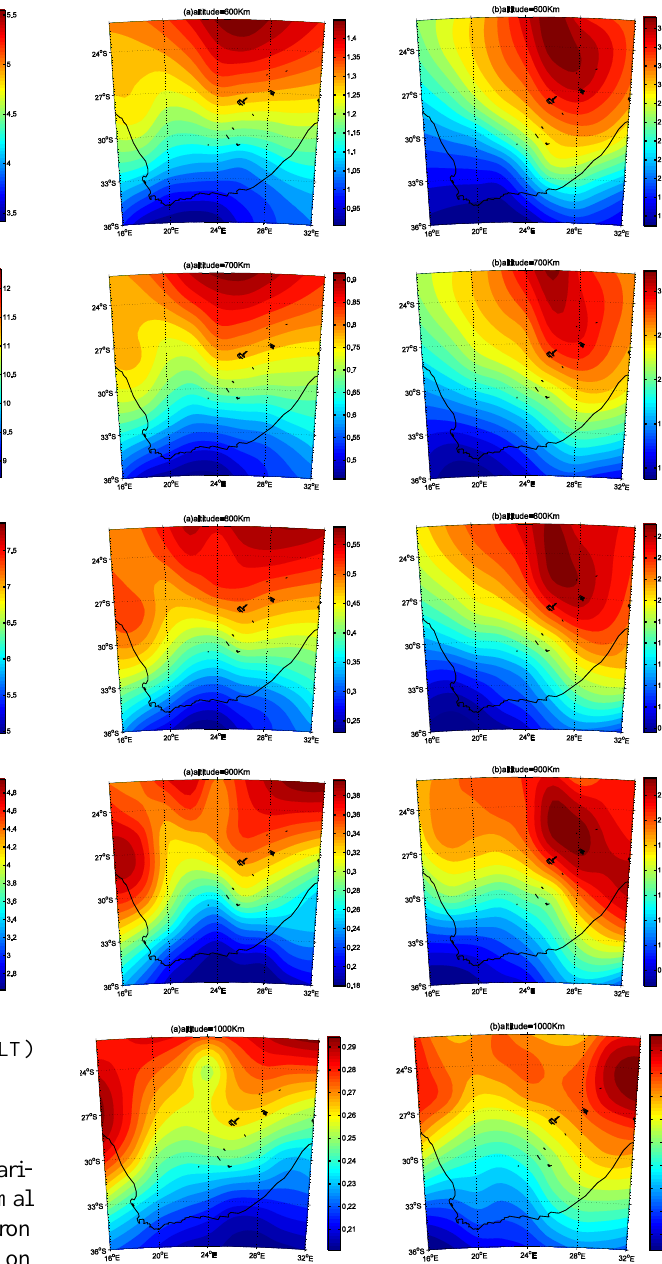
Figure 3 Electron density at different altitudes at 10:00UT (13:00LT) on (a) 14, (b) 15 May, 2005 (unit: 10 11 el/m 3 ). Fig. 3. Figure 4 shows a schematic of the temporal and spatial variations in electron density at an altitude of 350 km and a time interval of 2 hours from 04:00UT on May 14 to 20:00UT on 15May. Electron density significantly changed over time. For 40 hours, electron density generally exhibited a high-to-low trend, significantly increased, and then gradually decreased. On 14May, geomagnetic field activity was relatively calm, the electron density in the inversion region presented normal diurnal variations over time, and the changes in normal ionospheric electron density were influenced primarily by the sun. The peak electron density was 1.75×10 11 el/m 3 at 04:00UT, increased to 3.45×10 11 el/m 3 at 06:00UT, then gradually increased and reached a maximum of 6.85×10 11 el/m 3 at 12:00UT. The maximum electron density lasted 2 hours, then gradually decreased to 4.4×10 11 el/m 3 at 16:00UT. It presented a minimum of 1.5×10 11 el/m 3 at 02:00UT on 15May before beginning to increase again. On 15May, a strong magnetic storm occurred in the geomagnetic field, after which ionospheric electron density presented significantly abnormal changes. At a similar period on 14 May, the peak electron density at 06:00UT increased by an insignificant rate of 15.9%, i.e., 4×10 11 el/m 3 . At 08:00UT, peak electron density increased to 7.3×10 11 el/m 3 , a value 52% higher than the increase on 14 May. It presented significantly positive abnormal changes at 10:00UT and reached 1.2×10 12 el/m 3 , a value 81.8% higher than the increase on 14 May. At 12:00UT, peak electron density continued to present positive anomalies at 31.4% greater than those on 14 May. However, the ionospheric electron density in the inversion region presented negative anomalies at almost 6% less than those on 14 May. At 16:00UT, peak electron density presented positive anomalies at 37.5% greater than those on 14 May. At 18:00UT and 20:00UT, the anomalies increased to 73.6% and 22.2%, respectively.